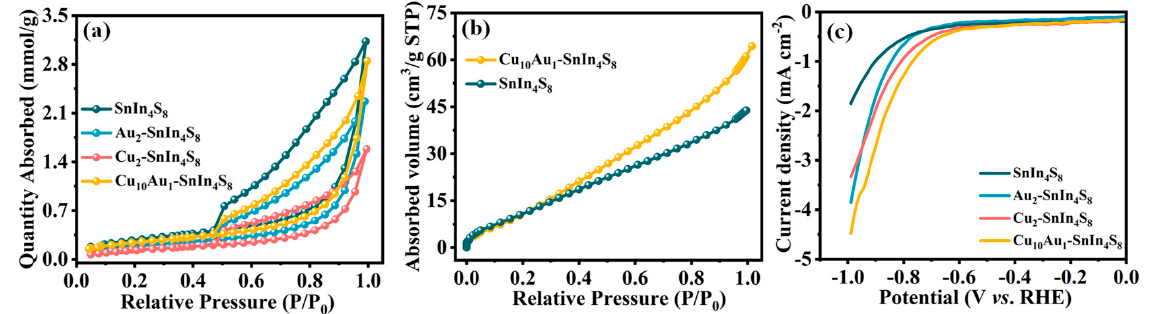
Figure 6. ( a ) N 2 adsorption–desorption isotherms of the samples, ( b ) CO 2 adsorption isotherms of SnIn 4 S 8 and Cu 10 Au 1 -SnIn 4 S 8 , ( c ) LSV curves tested in CO 2 of the samples.